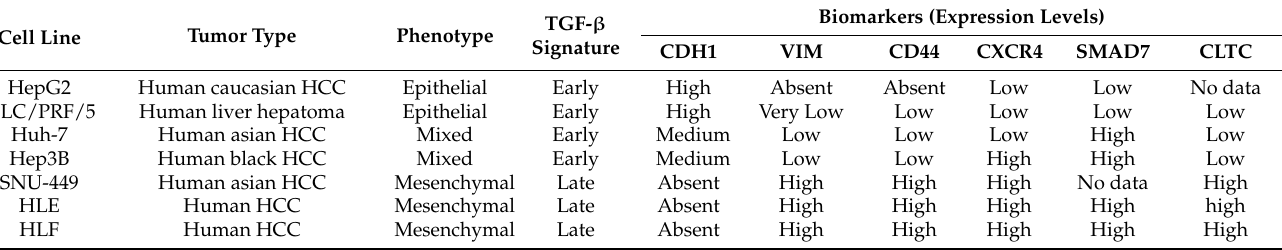
Table 1. TGF- β signature and biomarkers in human HCC cell